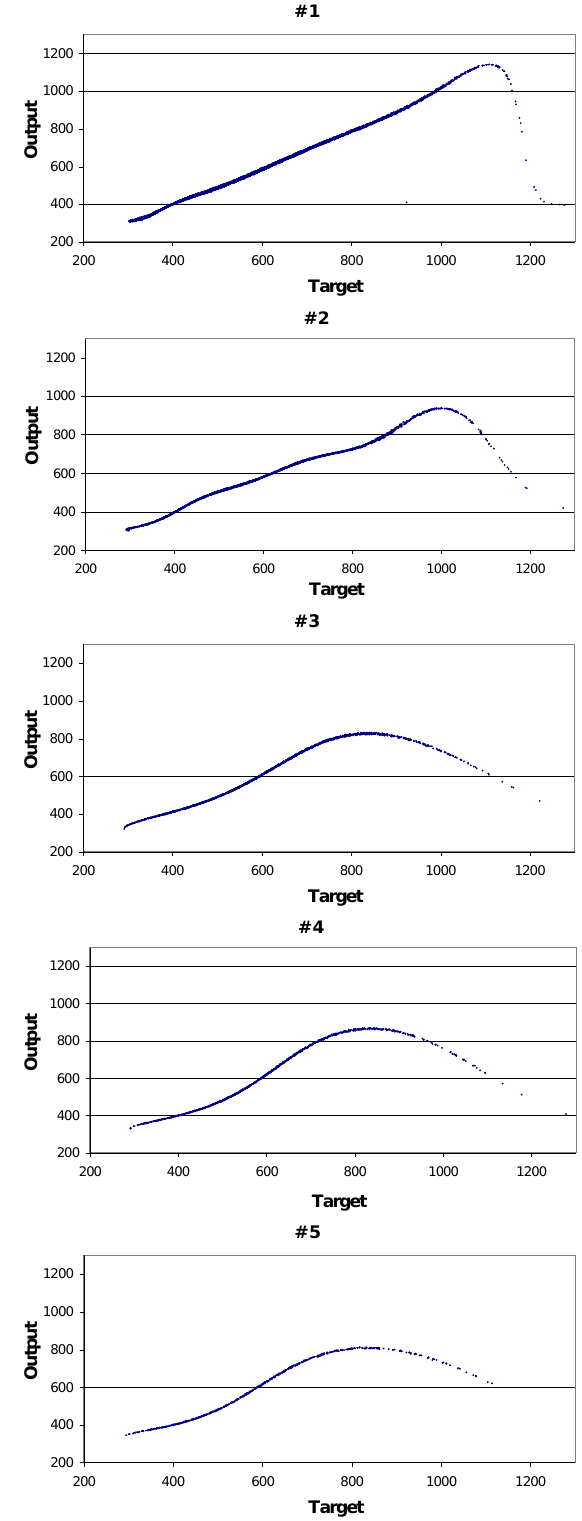
Fig. 5. Results of NN forecasts: outputs ( E ret predictions) vs. targets ( E ret real values) on the test set for the first eight classes of return-time